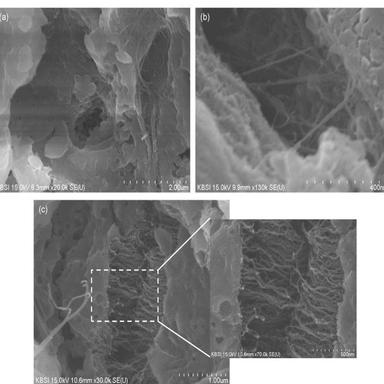
Scanning electron microscopy images of the samples with TWCNT content of (a) 0.2%, (b) 0.3%, and (c) 0.5%.